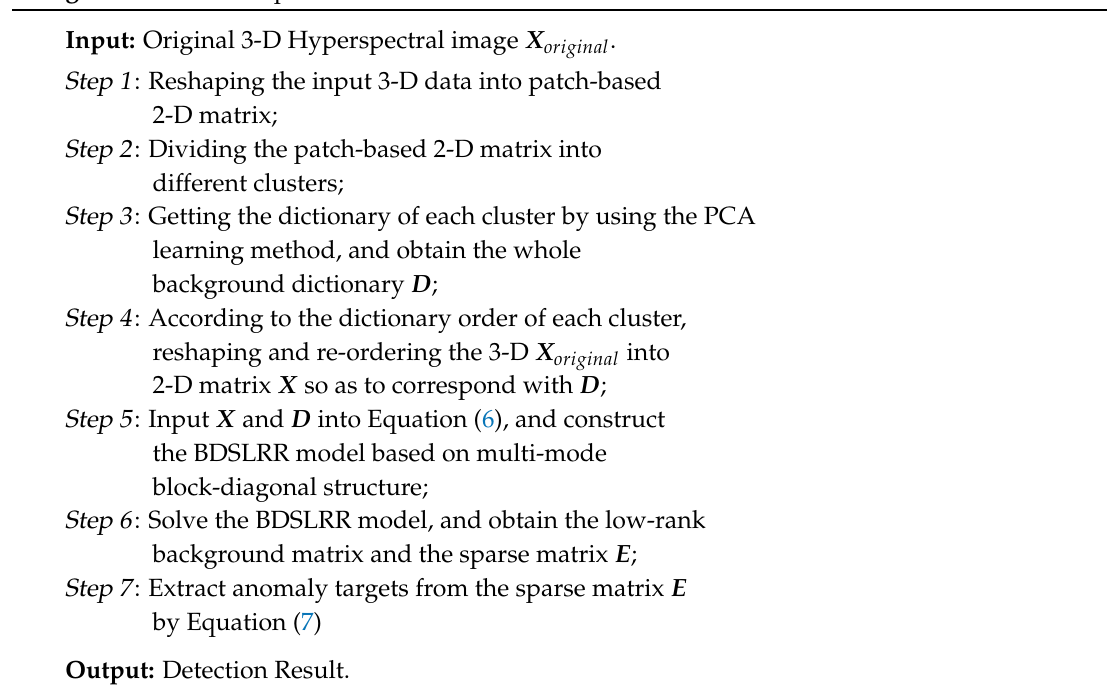
Algorithm 1: The Proposed BDSLRR